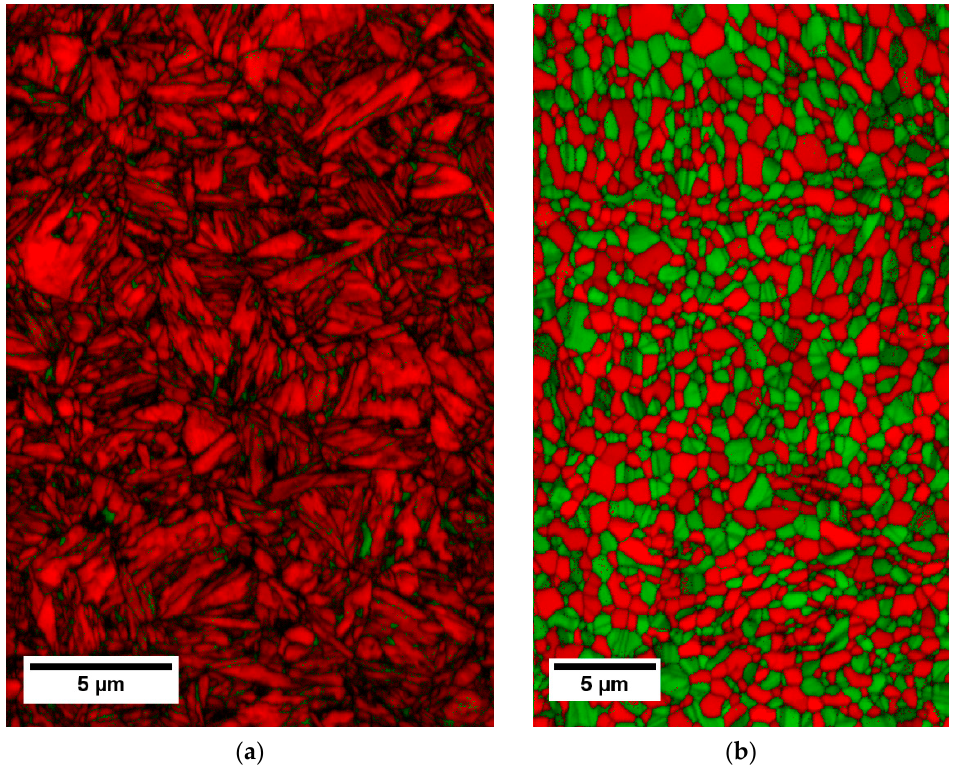
Figure 2. Combined EBSD phase map and image quality map showing the as-processed microstructures of ( a ) QP3Mn and ( b ) TRIP7Mn. Red indicates ferrite/martensite and green indicates austenite.